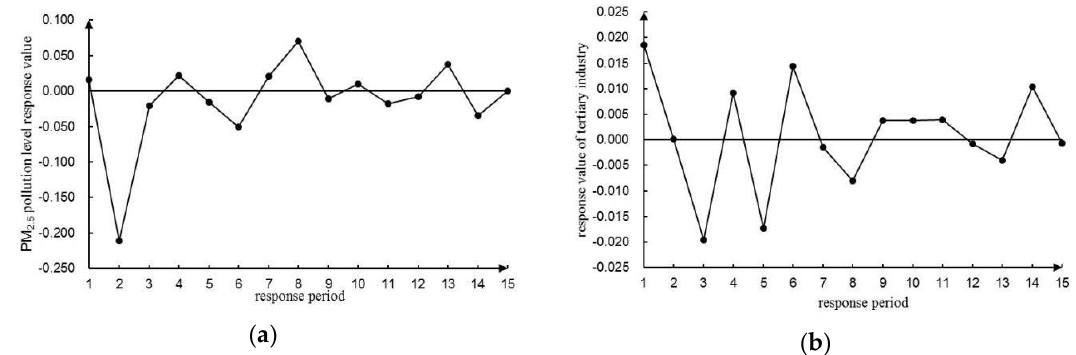
Figure 8. Impulse response function diagram of PM 2.5 pollution level and development level of the tertiary industry. ( a ) Impulse response function diagram of the PM 2.5 pollution level to the tertiary industry development level. ( b ) Impulse response function diagram of the tertiary industry development level to the PM 2.5 pollution level.